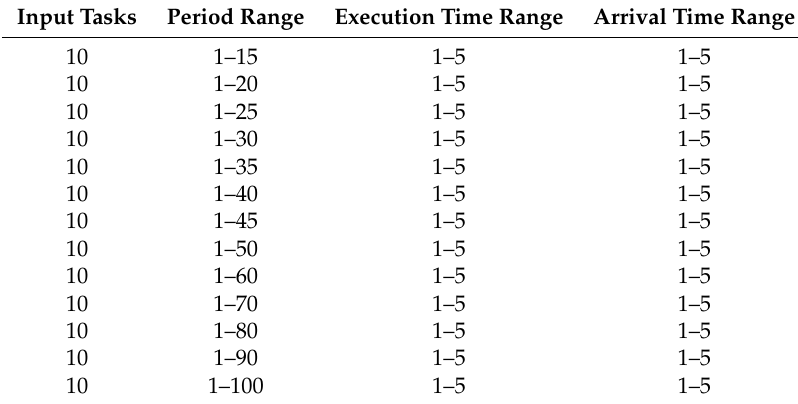
Table 5. Scenario: Varying period